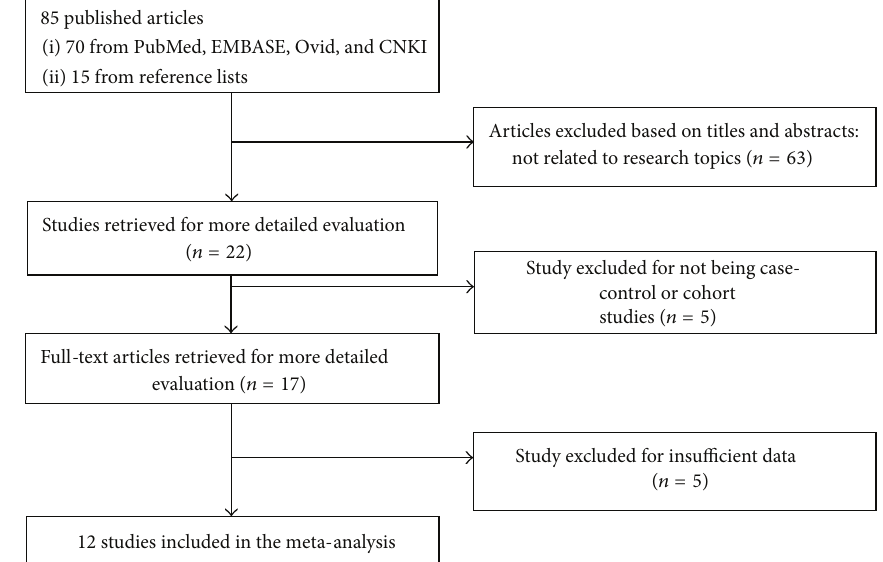
Figure 1: The flow diagram of the selection of